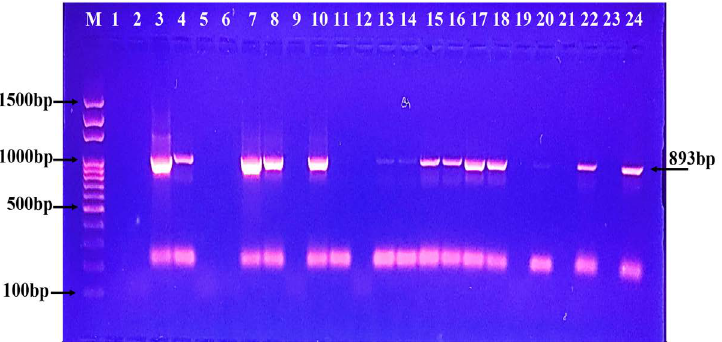
Fig. 4. Agarose gel electrophoresis of the bla 1500-100bp. Other lanes: positive amplification, 551bp